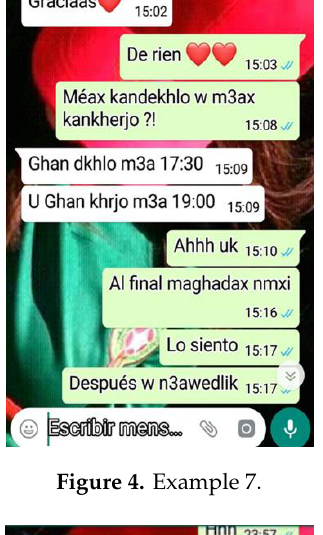
Figure 4 . Example 7. Figure 4. Example 7.